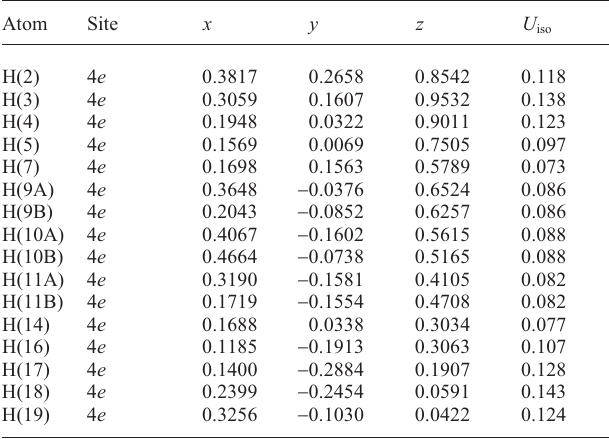
Table 2. Atomic coordinates and displacement parameters (in Å 2 )